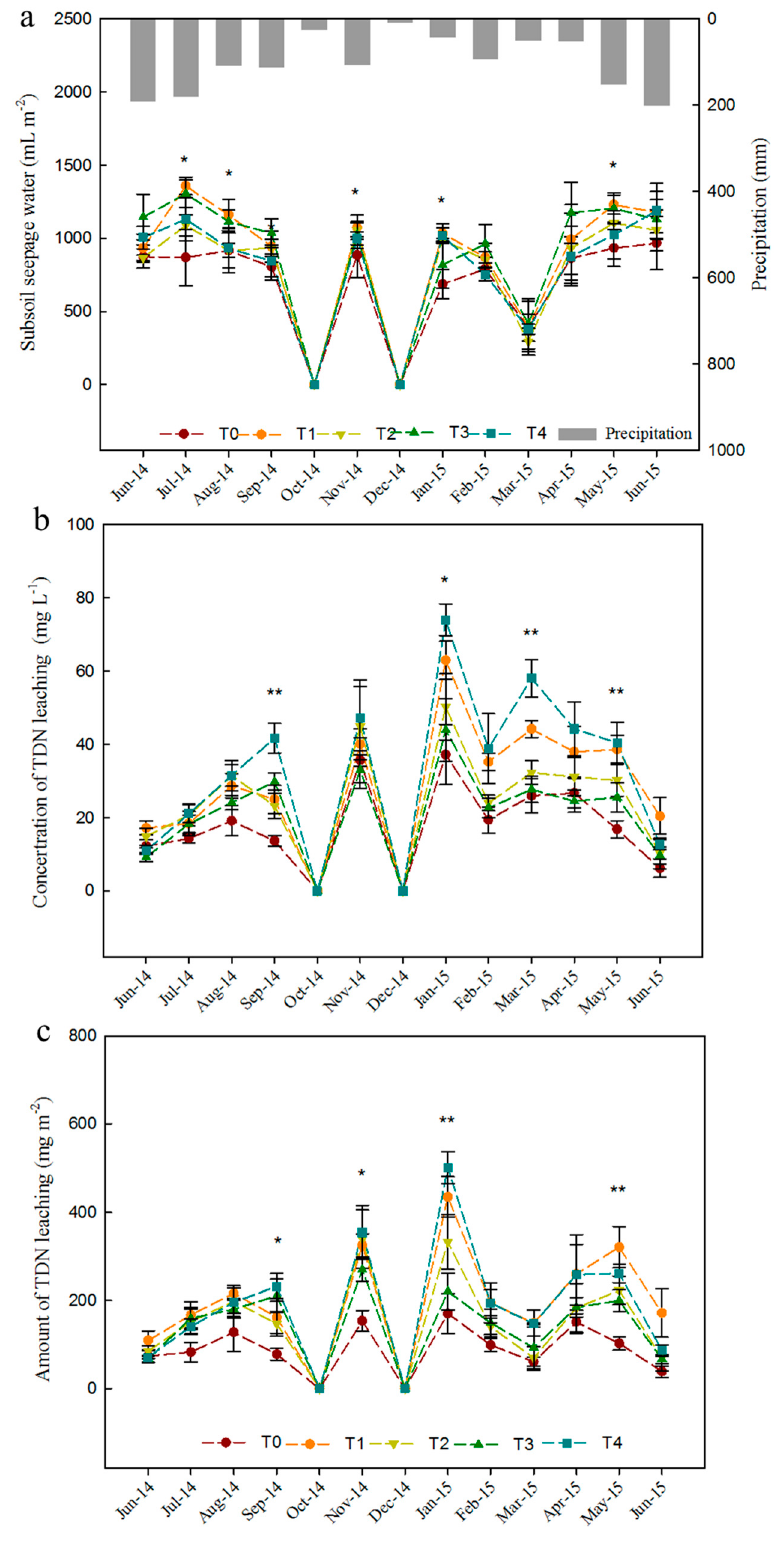
Figure 2. Precipitation and subsoil seepage water ( a ), concentration ( b ), and amount ( c ) of TDN leaching every month. T0, no tillage; T1, semiannual tillage; T2, tillage every four months; T3, bimonthly tillage; T4, monthly tillage. The asterisk (*) and (**) represent significant differences among different tillage treatments at the same time period (one-way ANOVA, p < 0.05 and p < 0.01, respectively). Bars represent mean ± standard error ( n = 4). TDN represents total dissolved nitrogen.